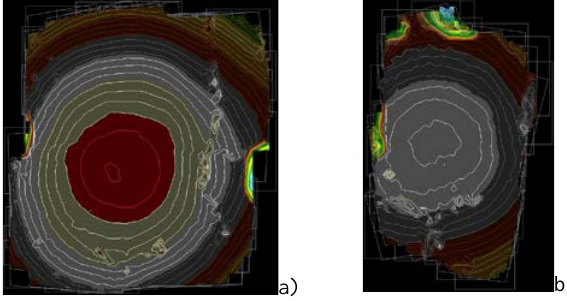
Figure 7: a) DSM of BezF1- b) DSM of BezF6. The “dome” in the center is erroneous. Contour interval